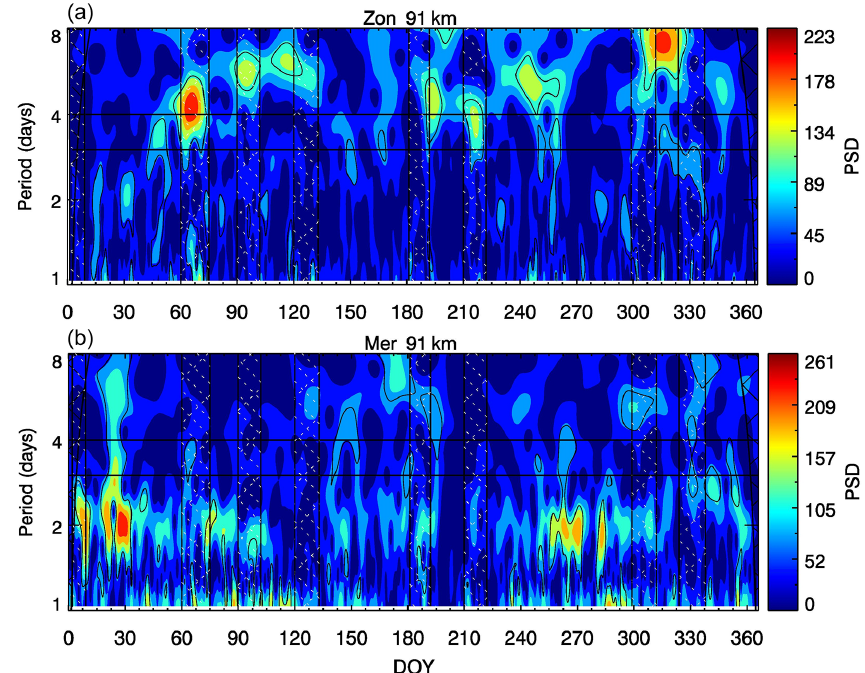
Figure 3. Wavelet spectra of the zonal (a) and meridional (b) wind at 91km in